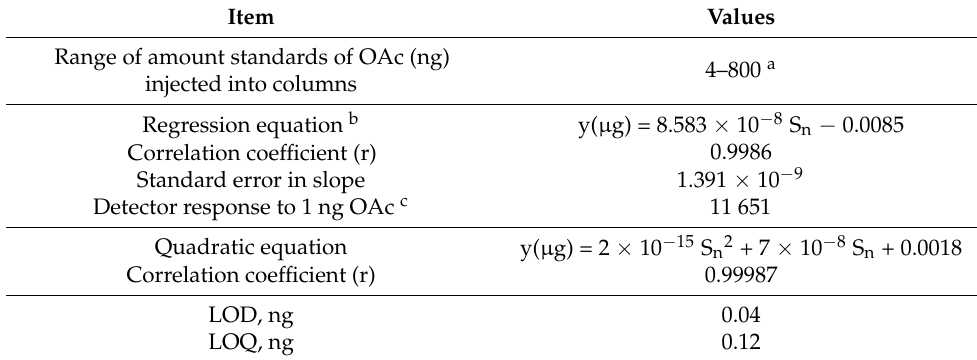
Table 3. Regression lines for the calibration curves, analysis of the linearity, standard error in slope, and the limit of detection (LOD) and quantification (LOQ) derived from determination of OAc in standards; UV detection at 278